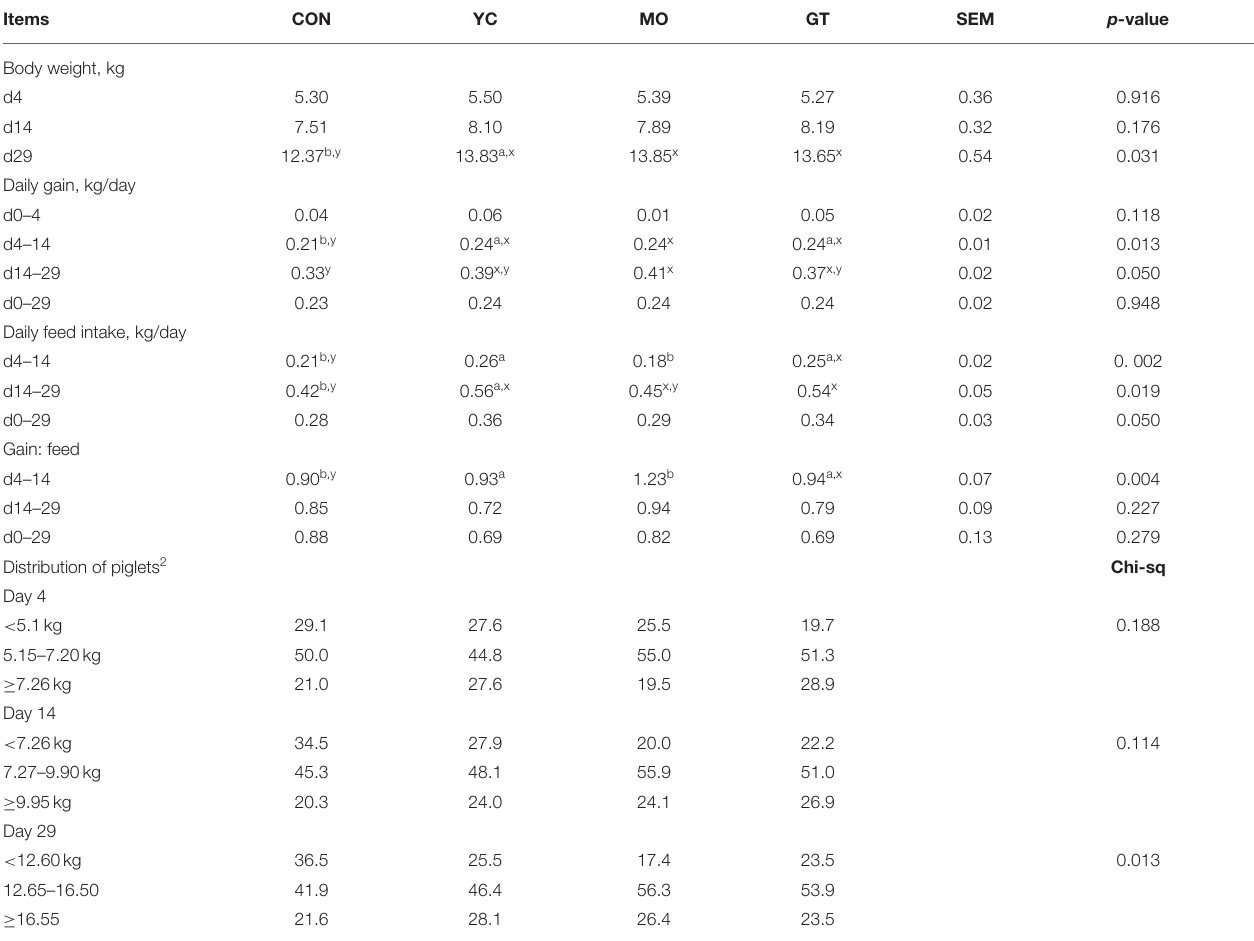
TABLE 7 | Performance of weaned pigs from d0 to 29 after weaning from sows provided feed additives in gestation and lactation (Study 2) 1,3,4